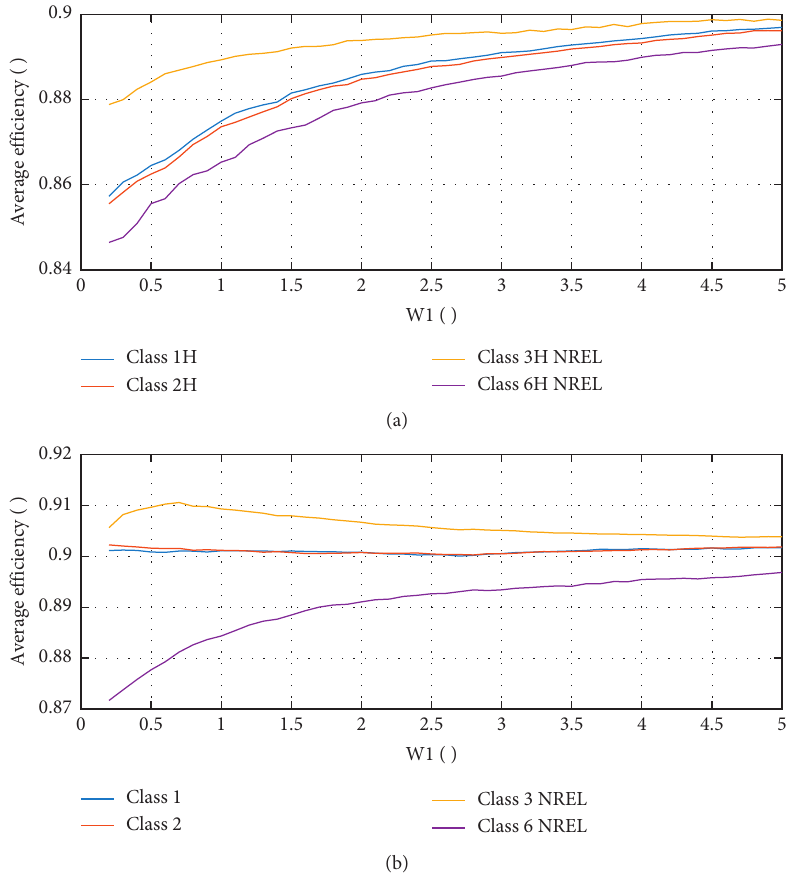
Figure 7: Efficiency value versus β